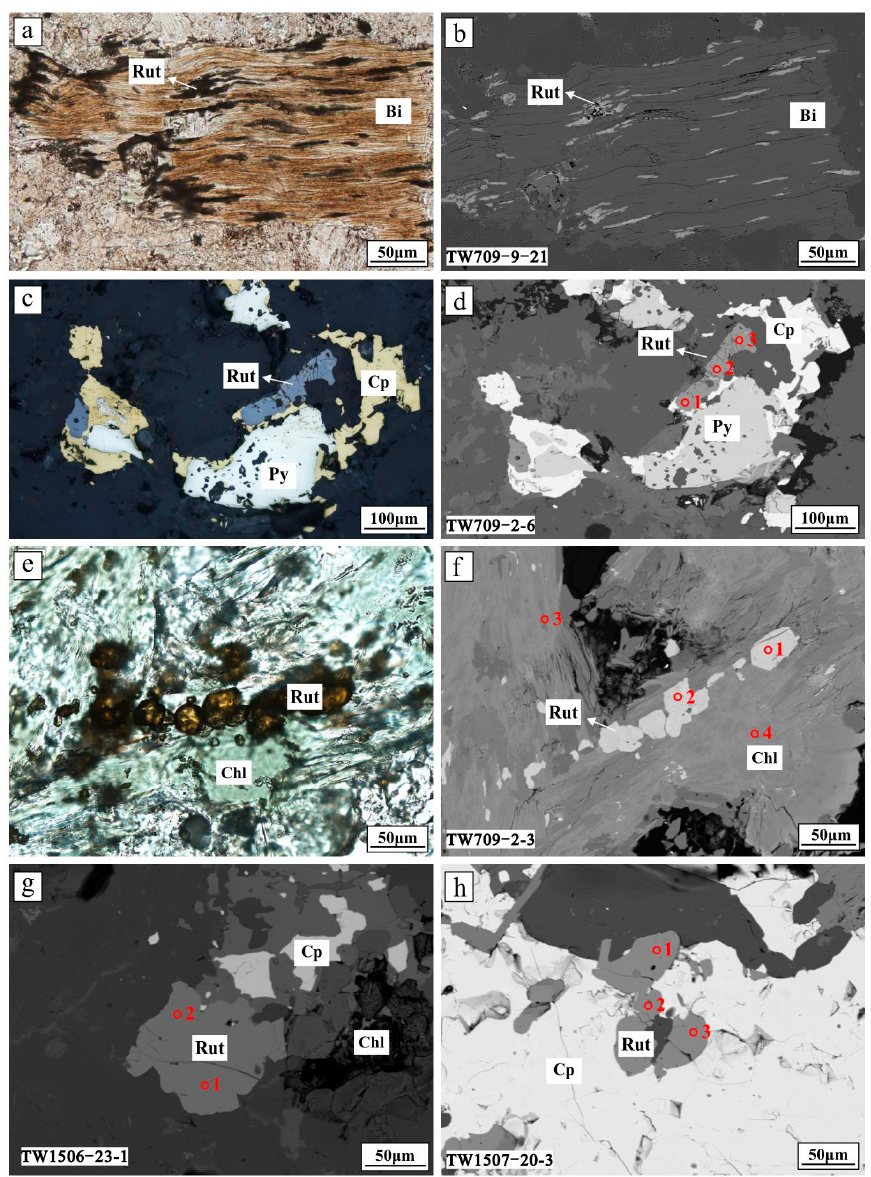
Figure 4. Photomicrographs and backscattered electron images (BSE) of rutile. ( a , b ) Rutile replaced early formed biotite (reflected light and BSE, respectively); ( c , d ) rutile with chalcopyrite and pyrite (reflected light and BSE, respectively); ( e , f ) rutile enclosed in chlorite (transmitted light and BSE, respectively); ( g ) rutile crystal coexisted with chlorite and chalcopyrite (BSE); and ( h ) rutile enclosed within chalcopyrite (BSE). Abbreviations: Bi = biotite; Chl = chlorite; Cp = chalcopyrite; Py = pyrite; Qz = quartz; Rut =